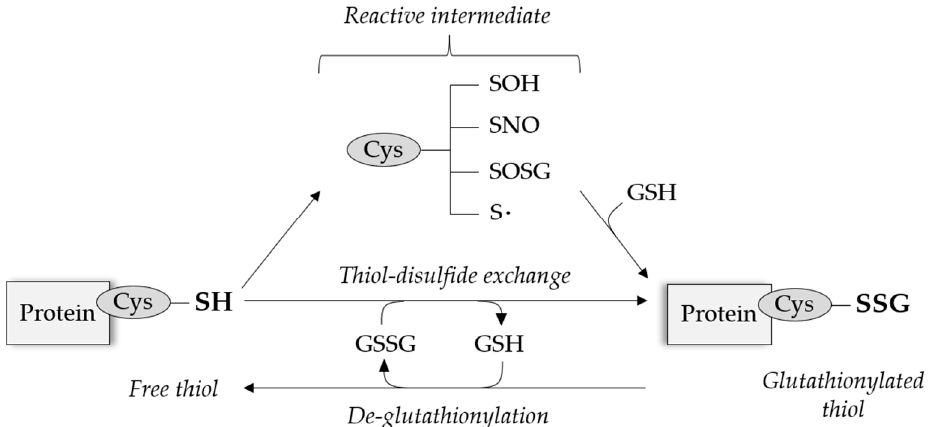
Figure 1. General mechanisms of reversible protein S-glutathionylation. Free thiols on reactive cysteinyl residues can be modified after the formation of an intermediate thiol derivative, or more rarely undergo direct thiol-disulfide exchange. S-glutathionylation can be reversed by the action of thiol-modifying enzymes, e.g., glutaredoxin (Grx). Cys = cysteine, GSH = glutathione.